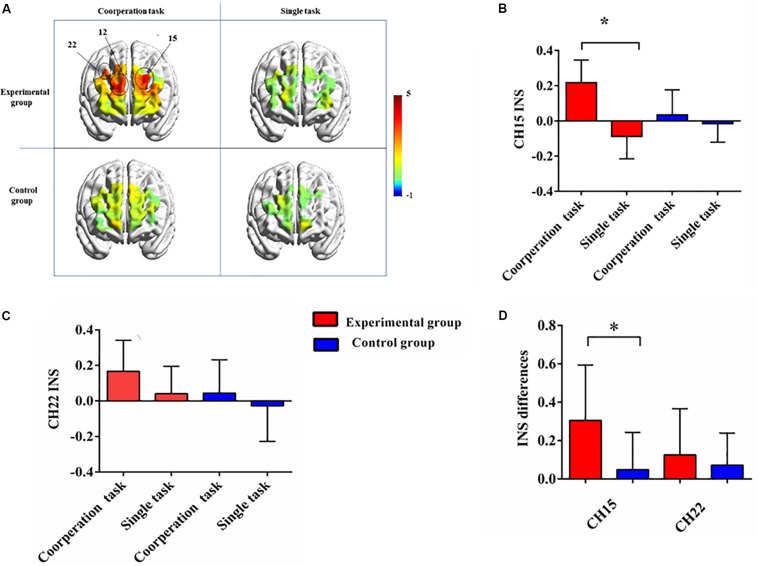
(A) T-maps of interpersonal neural synchronization of two groups in different conditions. For the experimental group, channel 12, channel 15, and channel 22 showed significant INS increase in the cooperative task. (B) The task-related INS in channel 15 of two groups in different tasks. (C) The task-related INS in channel 22 of two groups in different tasks. (D) The INS contrasts (cooperative task—single task) of two groups in channel 15 and 22. Error bars are standard errors. *designates p < 0.05.